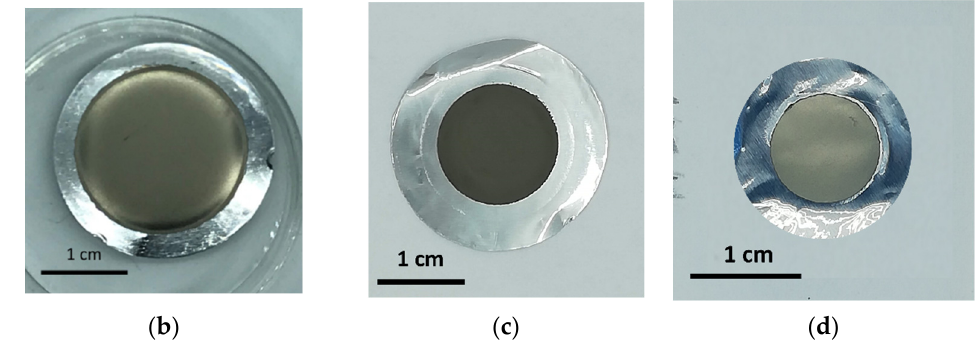
Figure 6. ( a ) Deposition area on Ø14 mm, 250 µm substrate (Cu) thickness; ( b ) deposition area on µm substrate (Al) thickness.